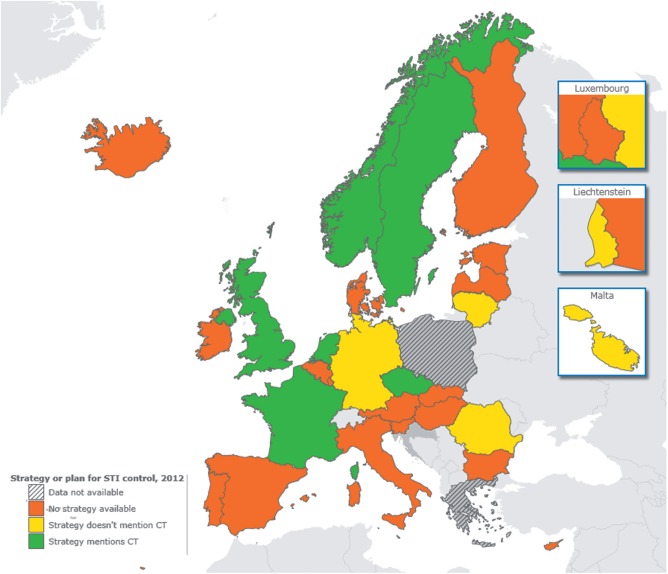
EU/EEA countries with a national strategy or plan about STI control in 2012. CT = chlamydia. UK situation based on England. Adapted from ECDC Report7